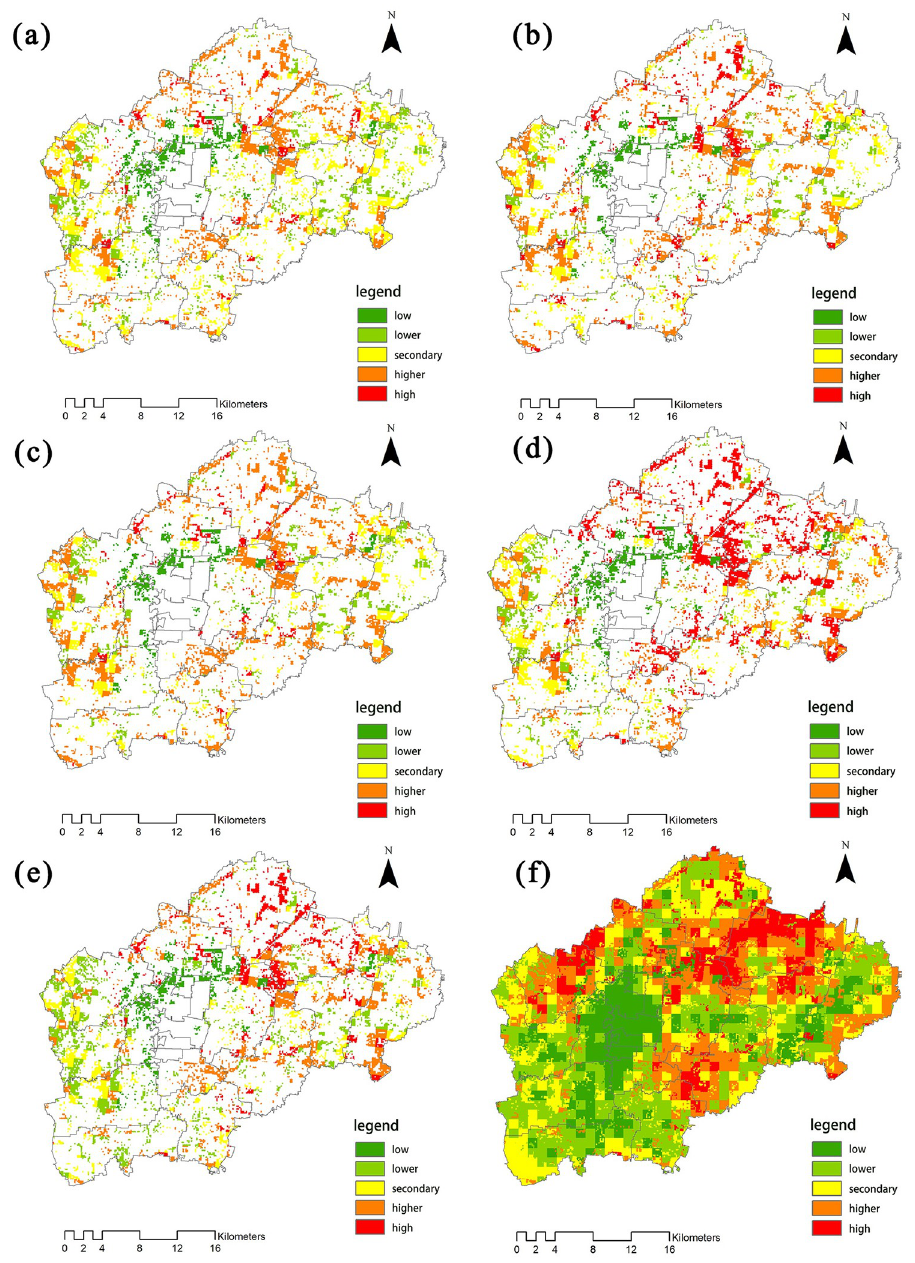
Fig 4. Spatial distribution of forest ecosystem service function intensity. Maps show the distributions of (a) the intensity of NPP, (b) the intensity of carbon sequestration, (c) the intensity of oxygen release, (d) the intensity of water conservation, (e) the intensity of biodiversity conservation, and (f) the intensity of